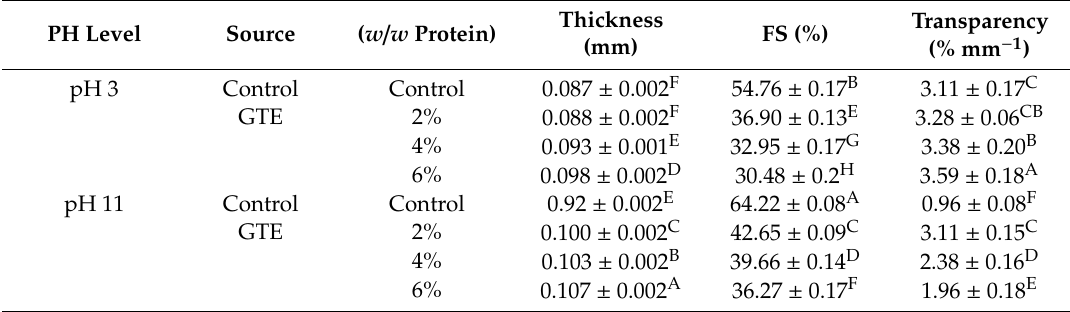
Table 1. Thickness, film solubility (FS), and transparency of films incorporated with green tea extract (GTE) at pH 3 or pH 11 with di ff erent